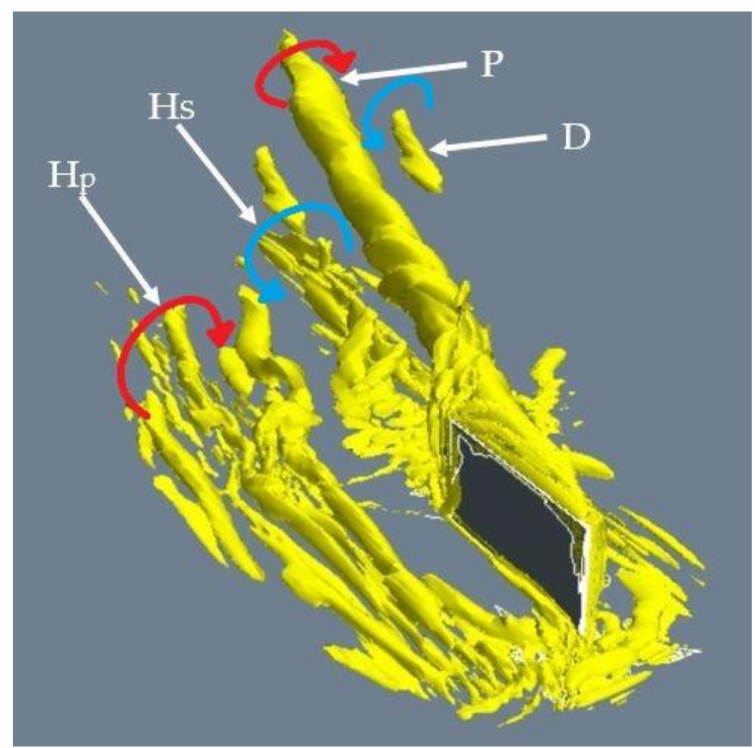
Figure 7. Vortex mechanisms in the wake behind a